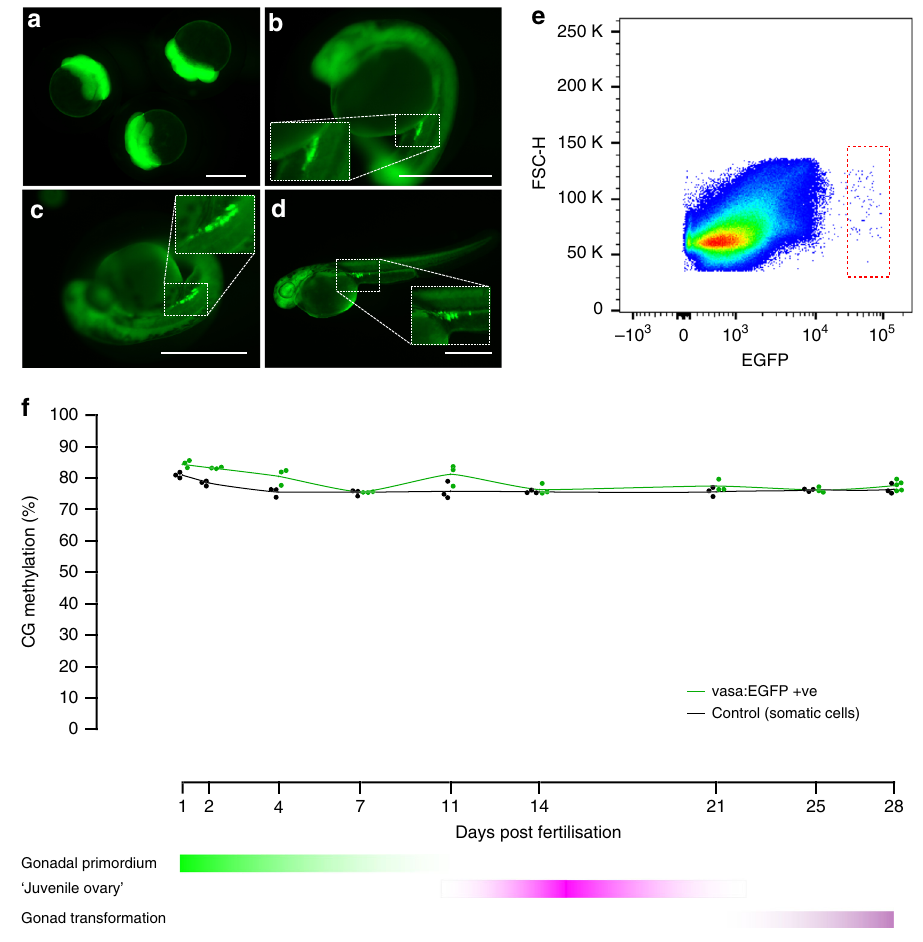
Fig. 1 Isolation and quantitation of DNA methylation in the zebra fi sh germline. a – d Fluorescence microscopy of tg(vasa:EGFP) zebra fi sh embryos and larvae. 1.5 h post-fertilisation (hpf) ( a ), 24 hpf ( b ), 48 hpf ( c – d ). 1.8× view of EGFP + ve labelled cells is shown inset (dashed lines). Scale bars are 500 µ m. Forward scatter height (FSC-H) e Flow cytometry plot of 10 zebra fi sh larvae at 48 hpf. The red dashed square indicates the EGFP + ve population gated for isolation. Blue dots indicate discrete data points (i.e., cellular events), whereas green, yellow and red colouring indicate increasing data density. f Percentage of methylation in CG context from 1 to 28 days post-fertilisation (dpf) in both vasa:EGFP + ve germline cells (green line) and control cells (black line). For each sample type and timepoint, n = 3 independent biological replicates were used, except for 28 dpf vasa:EGFP + ve, which has n =